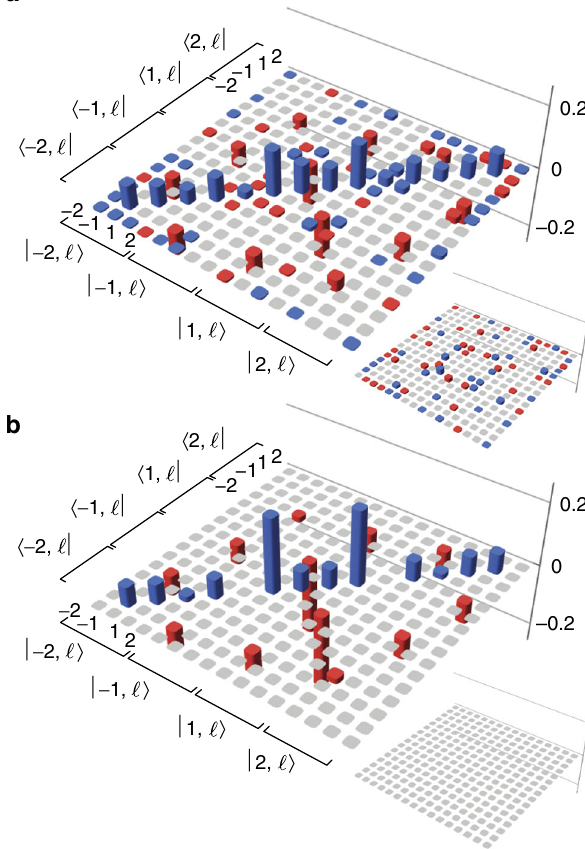
Fig. 3 High-dimensional state. Estimated density matrix of the joint state of A and D for the four-dimensional space with ‘ ¼ ± 1 ; ± 2. a The state estimated using the reconstructed density matrices of all six two- dimensional subspaces in Eq. (3). b The theoretical prediction using the experimentally observed spiral bandwidth. Positive values are shown in blue , while negative values are shown in red ; grey indicates the element is unmeasured in a or zero in